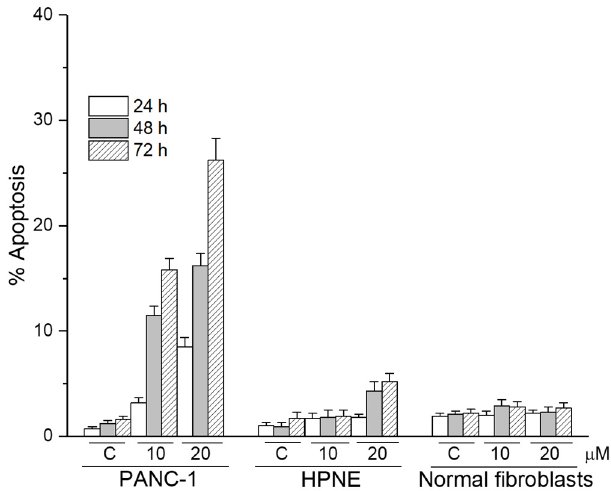
Figure 8. Differential capacity of edelfosine to induce apoptosis between pancreatic cancer cells and nontumorigenic cells. Human PANC-1 pancreatic cancer cells, nontumorigenic HPNE and normal fibroblasts show a different sensitivity to undergo apoptosis following treatment with edelfosine for the indicated incubation times and drug concentrations. The data are shown as the means ± SD of three independent experiments.